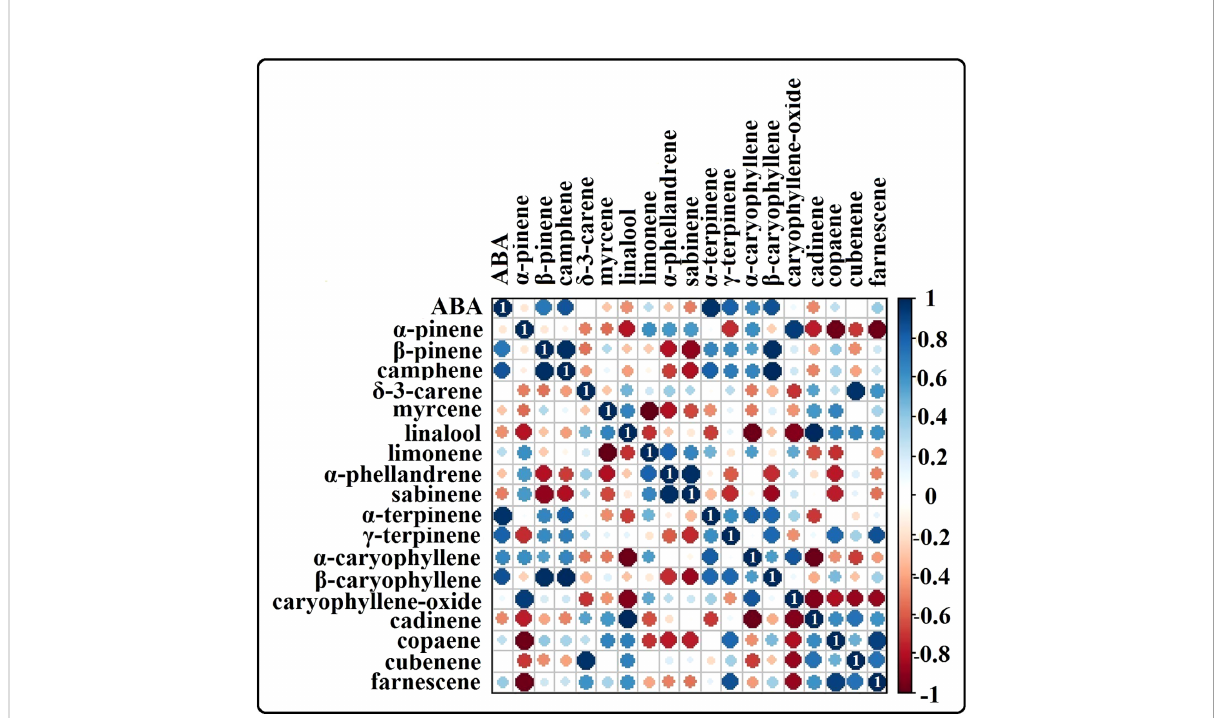
FIGURE 6 Heat map showing the correlation analysis of ABA content vs terpene content from our study. Positive correlation between ABA and the terpenes are shown in ‘ blue ’ and negative correlation between ABA and terpenes are shown in the color range ‘ red ’ . Results highlight a strong positive correlation between several monoterpenes like a -pinene, camphene, a -terpene, y-terpinene and ABA whereas negative/weak positive correlation is observed for several sesquiterpenes like caryophyllene oxide, cadinene, copaene, cubenene and farnescene in relation with